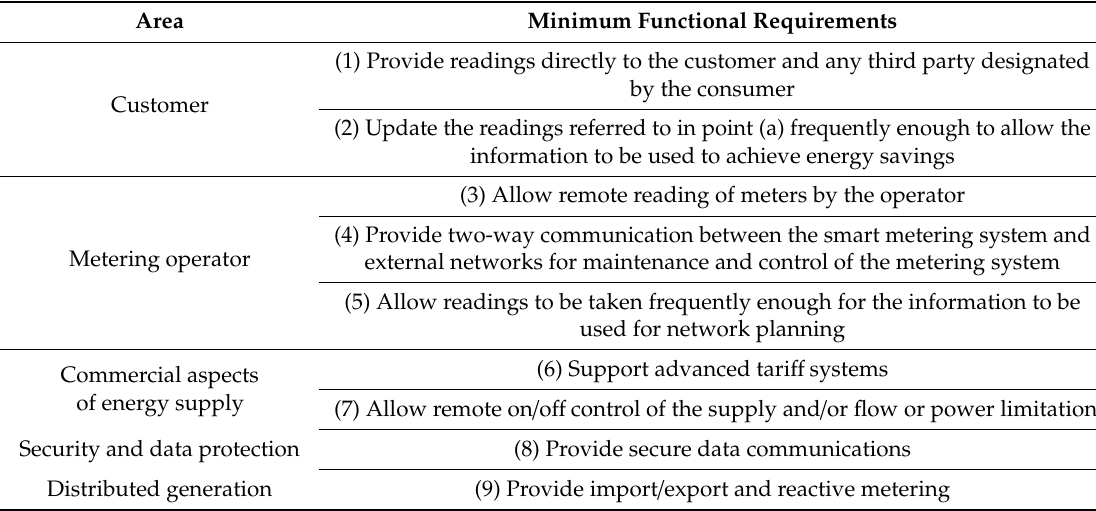
Table 4. Specification of common minimum functionalities of smart meters (Reproduced under CC BY 4.0, European Commission. (2012 / 148 / EU) Commission Recommendation of 9 March 2012 on Preparations for the Roll-out of Smart Metering Systems; Brussels: European Commission, 2012).